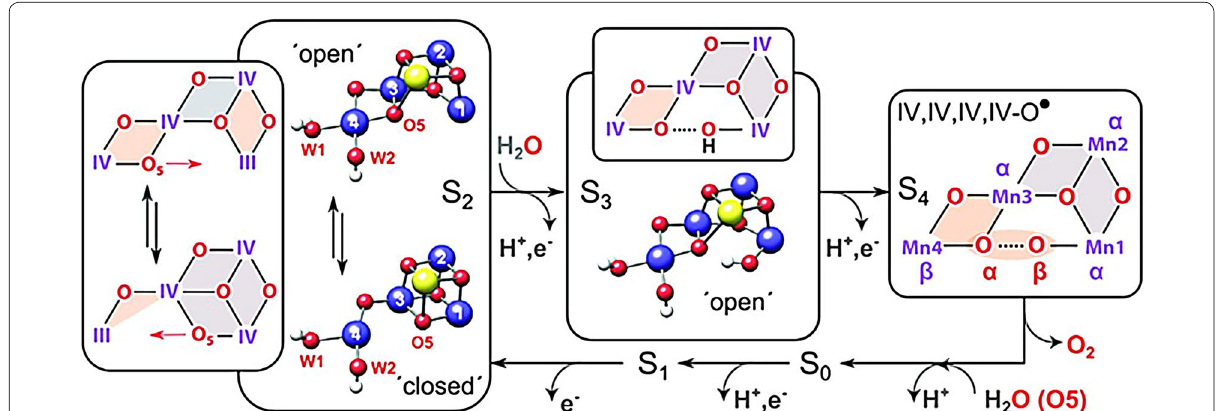
Fig. 2 Theoretically calculated structures for the S2 and S3 states and the proposed mechanism of O–O bond formation (Adapted with permission from [35]. Copyright 2014, AAAS the science society